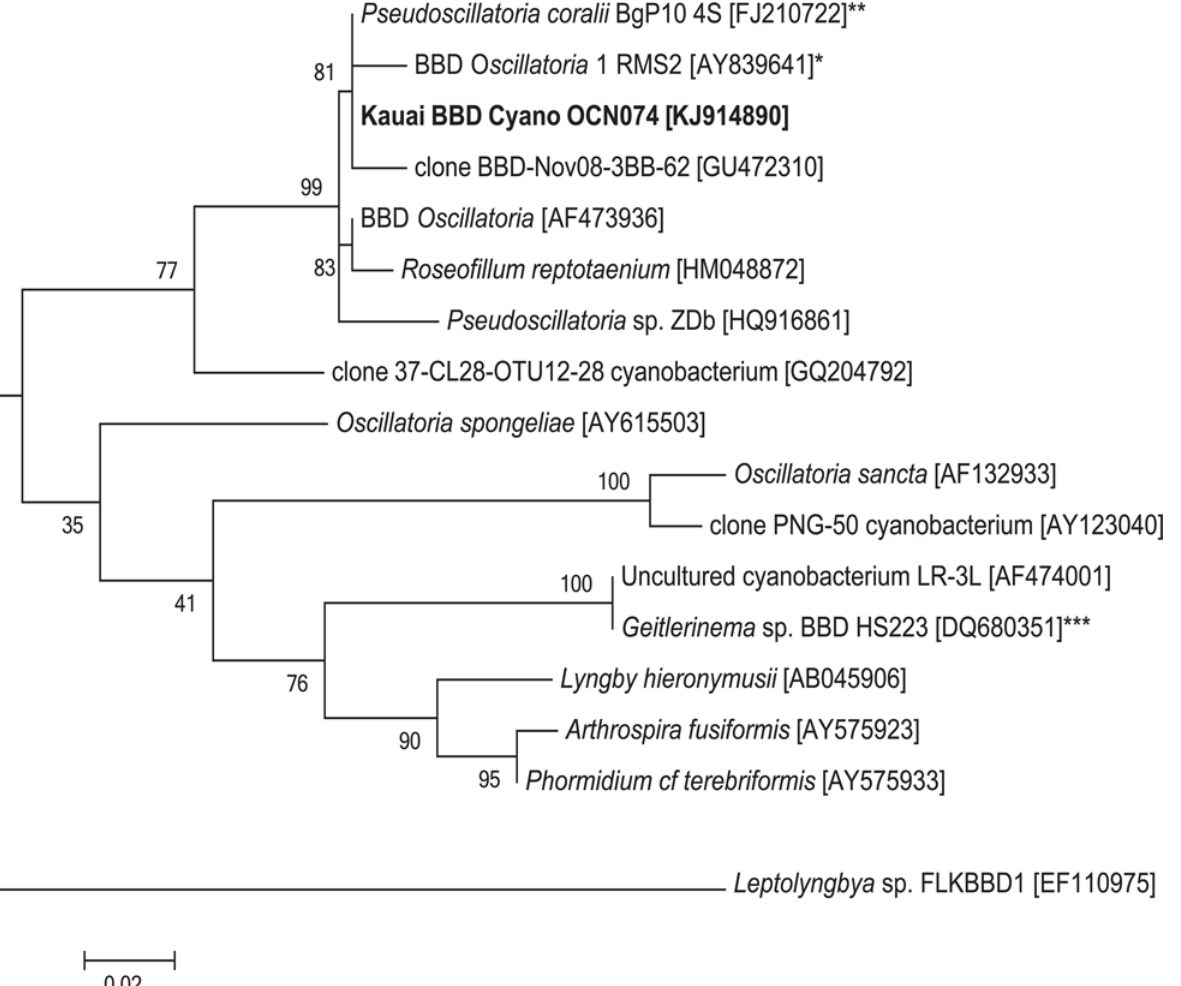
Fig 4. Phylogenetic relationship of cyanobacterium OCN074, isolated from disease lesions from Kaua ‘ i, to other cyanobacteria. All 16S rRNA gene sequences from the three Kaua ‘ i BBD cyanobacterial isolates were identical. A phylogenetic tree was generated using the Maximum Likelihood method. The ‘ * ’ indicates cyanobacteria associated with BBD of Palau ( * [42]) the Red Sea ( ** [41]), and the Florida Keys ( *** [43]). The tree with the highest log likelihood is shown, and 1000 bootstrap replicates were used. NCBI accession numbers are in brackets and bootstrap values are indicated at branch nodes. Scale bar represents two substitutions per 100 nucleotide